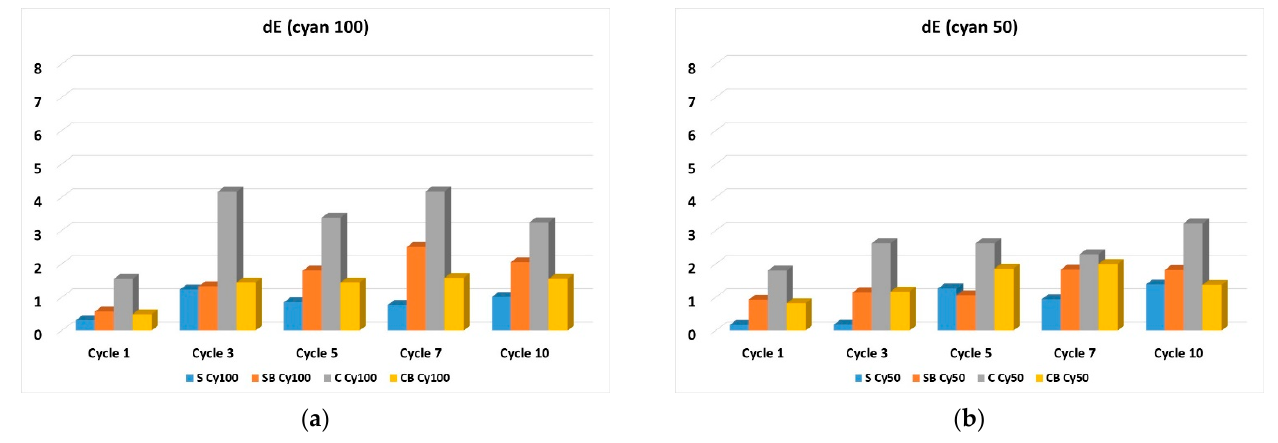
Figure 9. Total colour differences (dE) for washed samples compared with samples before washing, for cyan colour hue: ( a ) 100% ( b ) 50% of pigment.